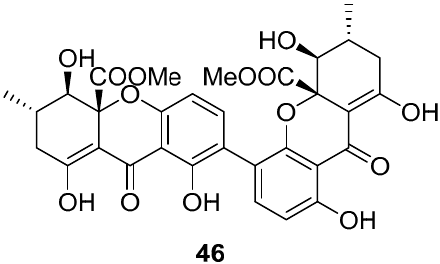
Figure 20. Structure of penicillixanthone A ( 46 ).